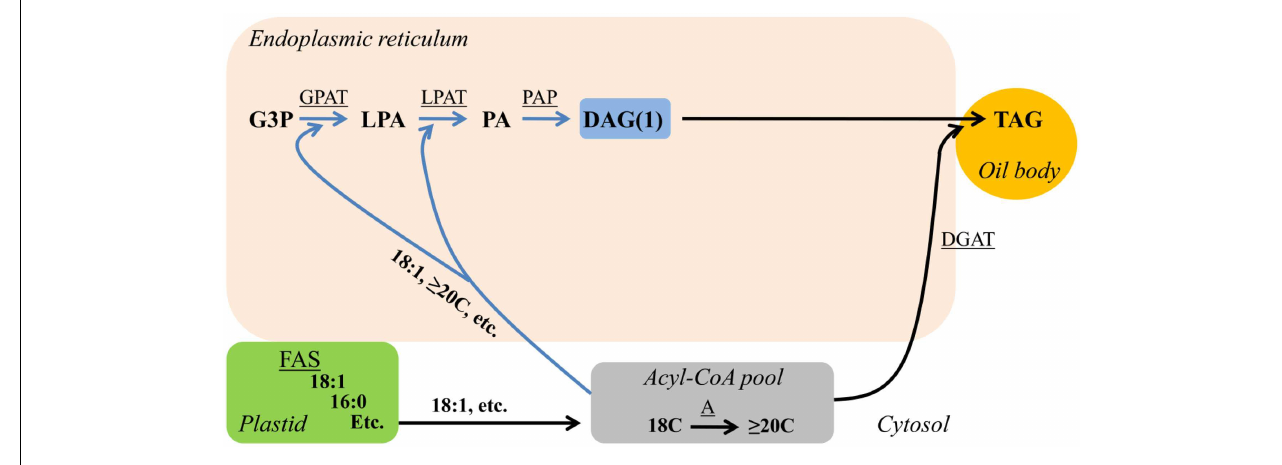
TAG, triacylglycerol. Enzymatic reactions are underlined: A, FA elongation; DGAT, acyl-CoA:DAG acyltransferase; FAS, fatty acid synthesis; GPAT, acyl-CoA:G3P acyltransferase; LPAT, acyl-CoA:LPA acyltransferase; PAP, PA